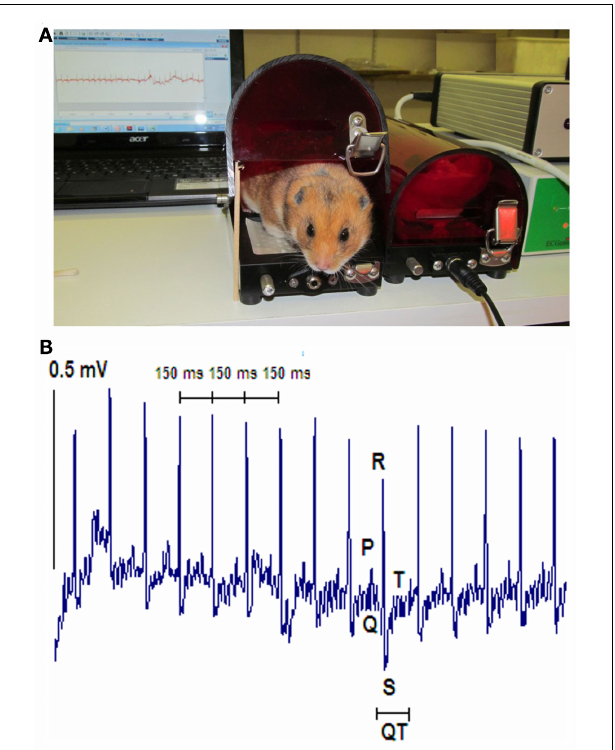
FIGURE 1 | (A) Adult ( ∼ 9 months old) F1B control hamster exploring an ECGenie™ recording enclosure just prior to the lid being closed to prevent escape; to the right aTO-2 hamster can be seen inside an ECG recording enclosure.The ECG is detected passively through the underside of the subject’s paws as it rests atop two electrodes embedded in the enclosure floor. (B) Representative ECG signals, a subset from ∼ 100 continuous ECG complexes recorded over ∼ 15s, acquired non-invasively from a conscious adultTO-2 hamster.The PQRST morphology is indicated; note the high regularity in the RR intervals in this cardiomyopathic